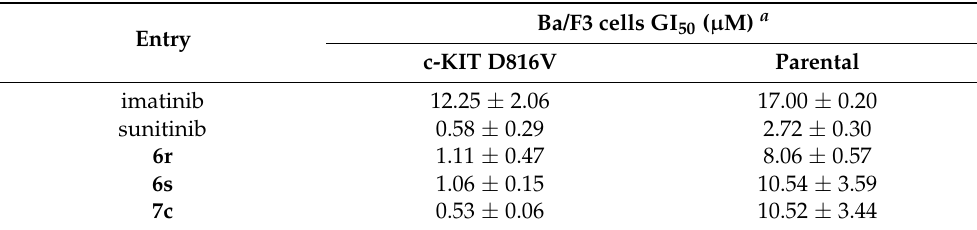
Table 4. Anti-proliferative activities of thiazolo[5,4- b ]pyridine derivatives 6r , 6s , and 7c against c-KIT D816V Ba/F3 cells and parental Ba/F3